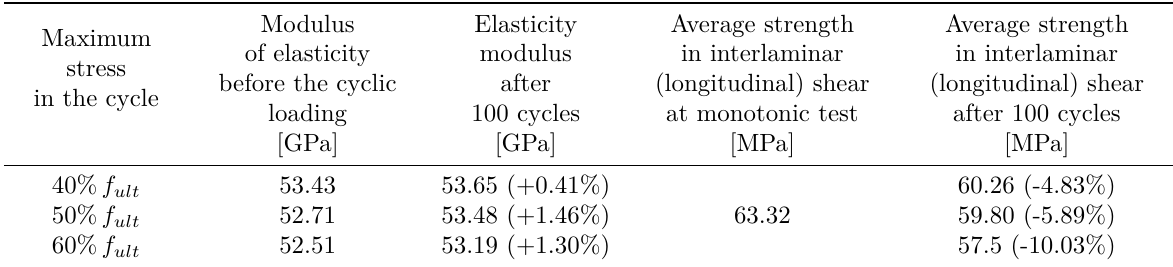
Table 2. Comparison of mechanical properties.